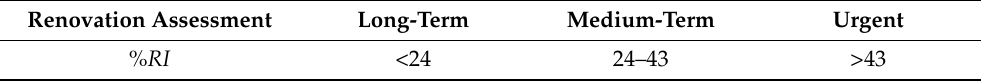
Table 5. Renovation judgement from the % RI assessment result.